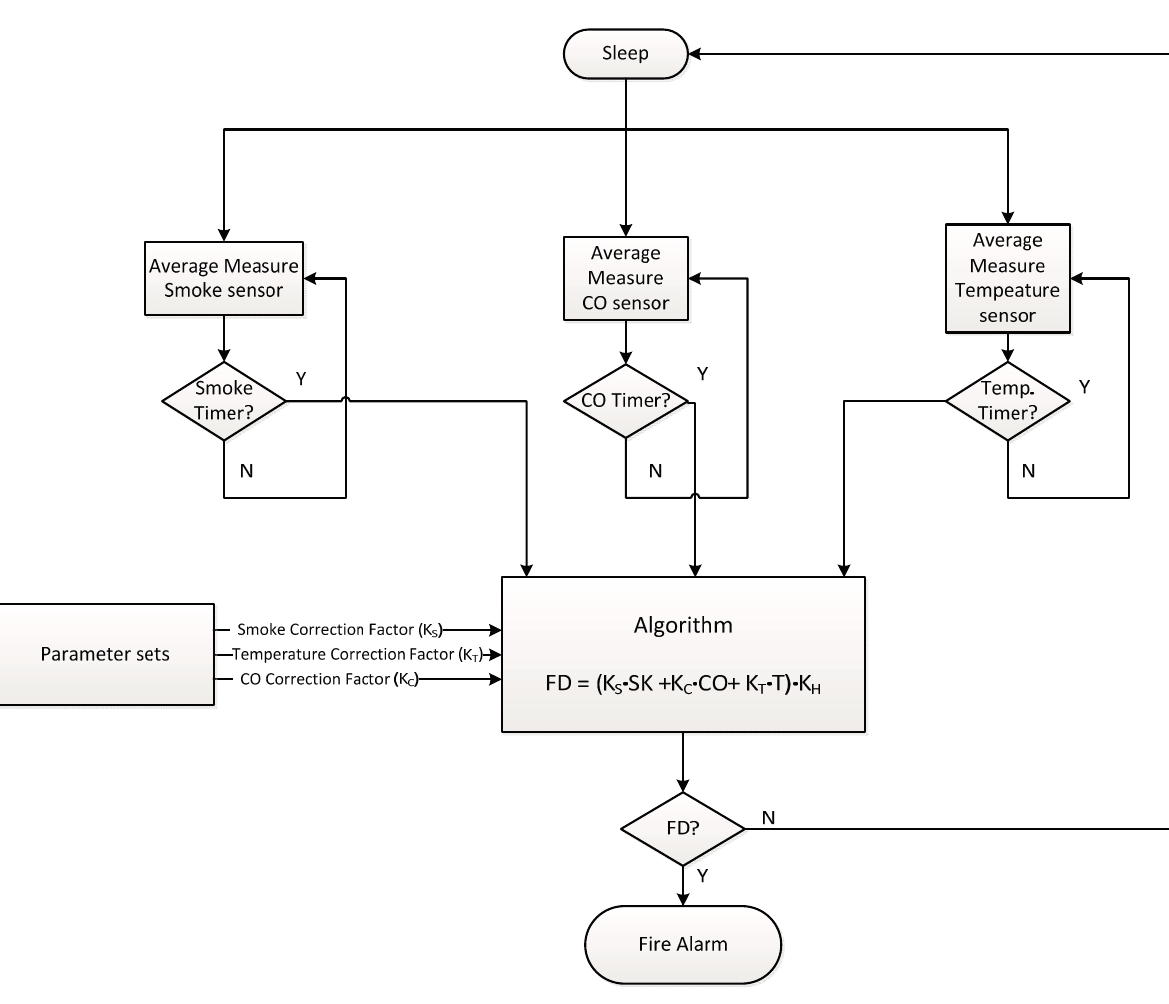
Figure 11. Flow chart of the detection